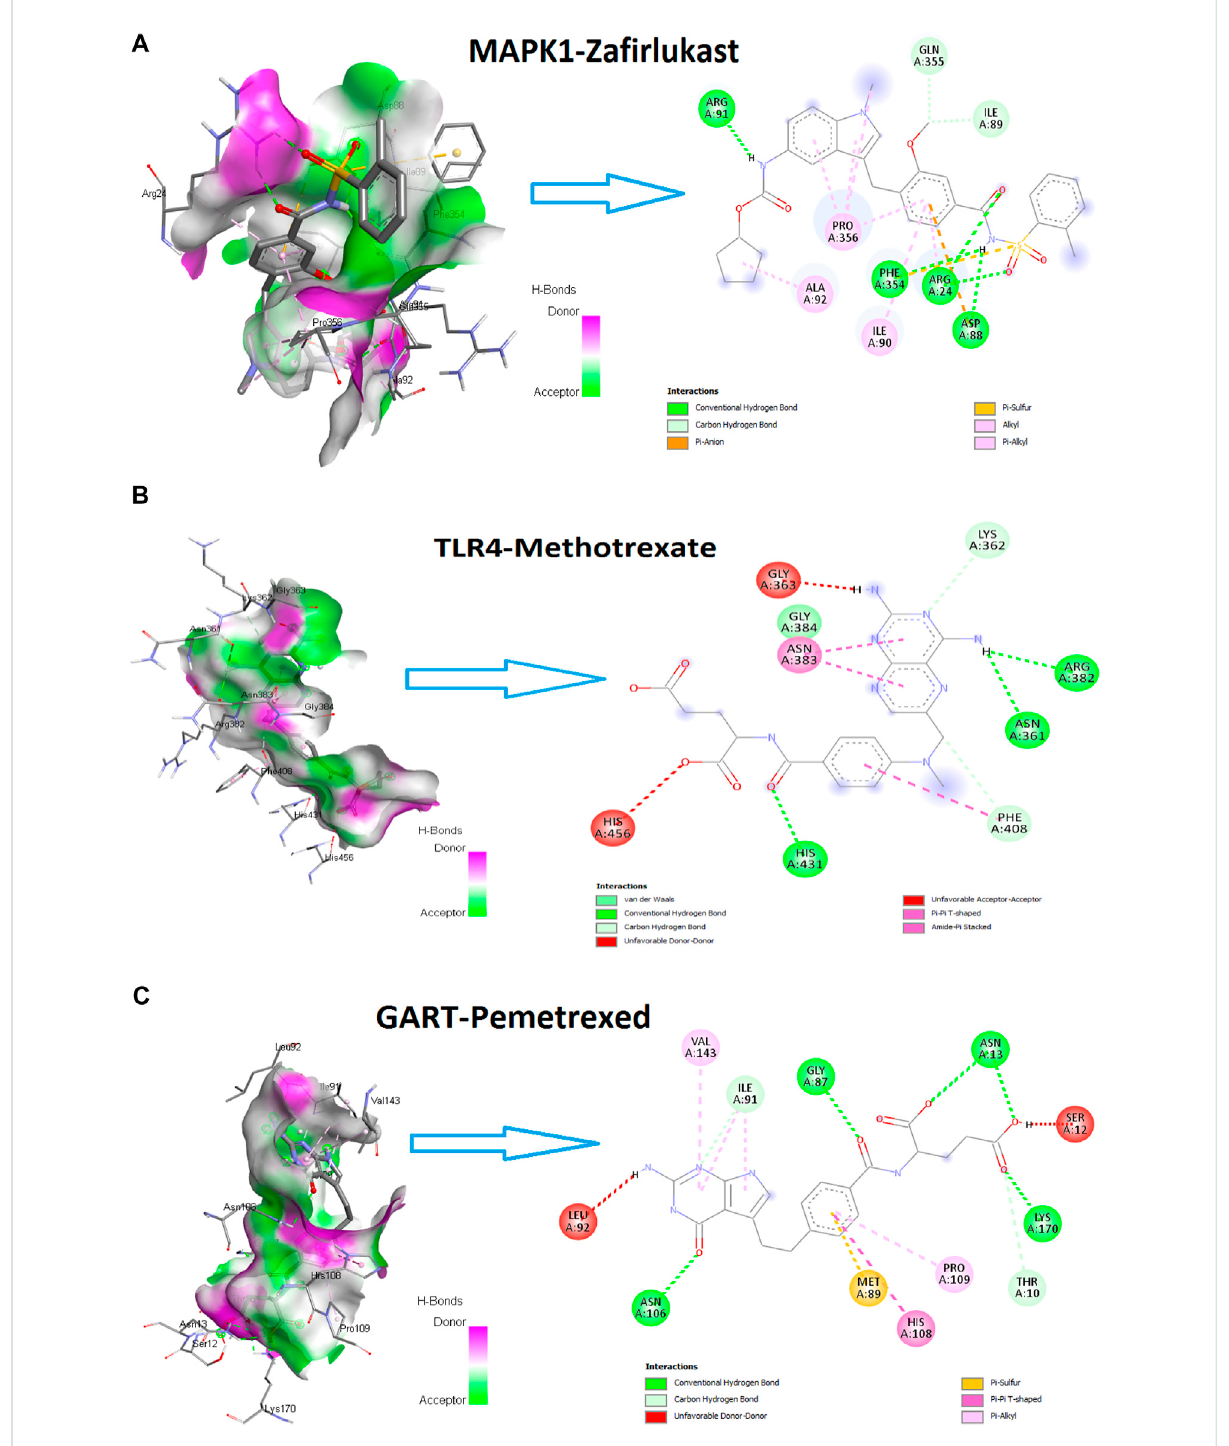
FIGURE 13 The hub proteins ’ interaction (3D and 2D) with their targeting drugs. (A). The 3D and 2D interaction of Za fi rlukast with MAPK1. The binding af fi nity of thisinteraction is − 9.9. (B). The 3Dand 2D interaction of methotrexate with TLR4. The binding af fi nity ofthisinteraction is − 7.7. (C). The 3D and 2D interaction of Pemetrexed with GART. The binding af fi nity of this interaction is −